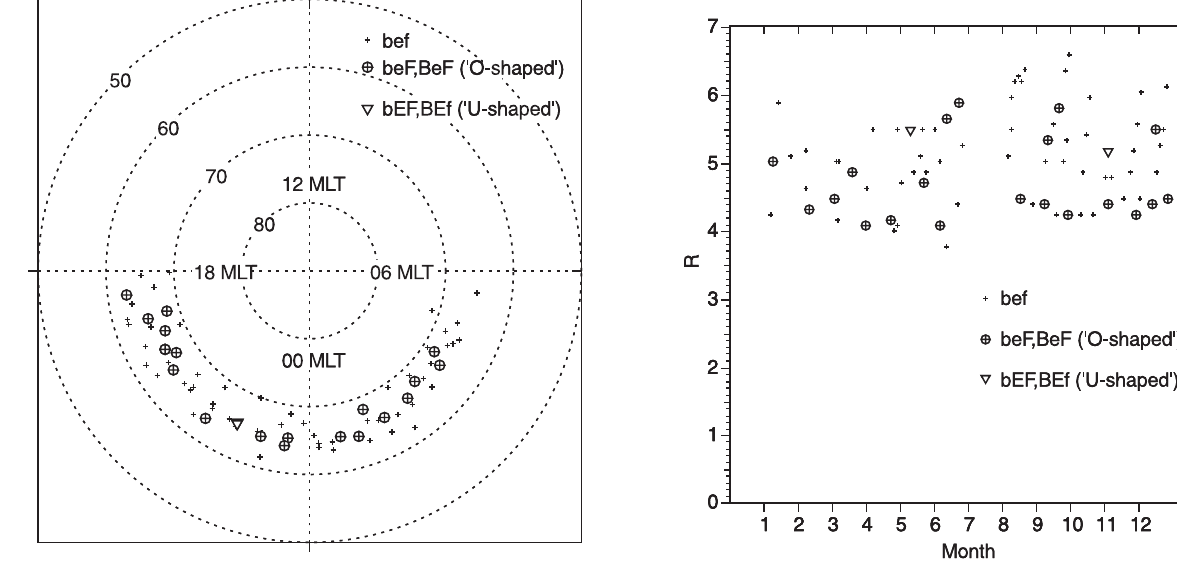
Fig. 9. Same as Fig. 7, showing the seasonal distribution of